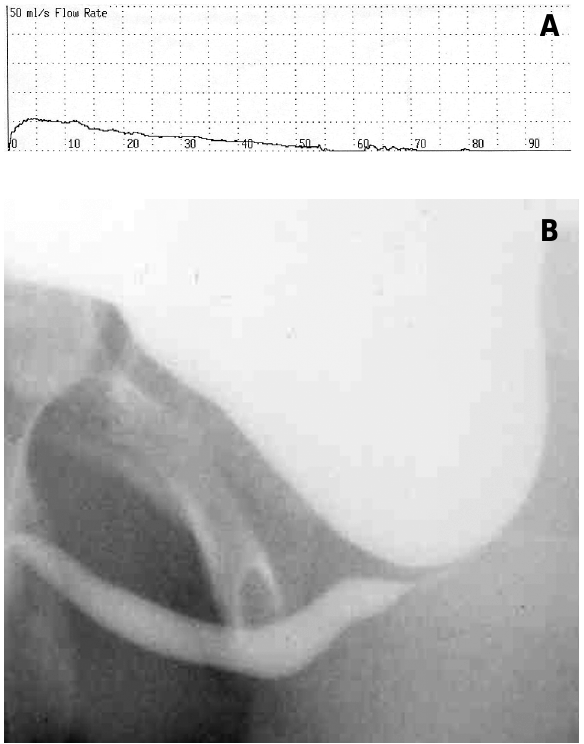
Figure 3 – Ultrasound of the thick-walled bladder of the 11 year old